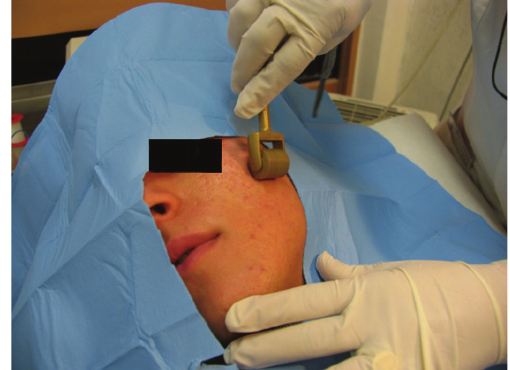
Figure 6: Needling: the procedure.